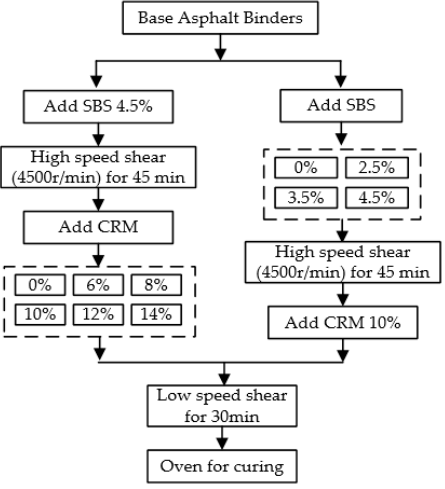
Figure 1. Production of hybrid modified binders with SBS and CRM.